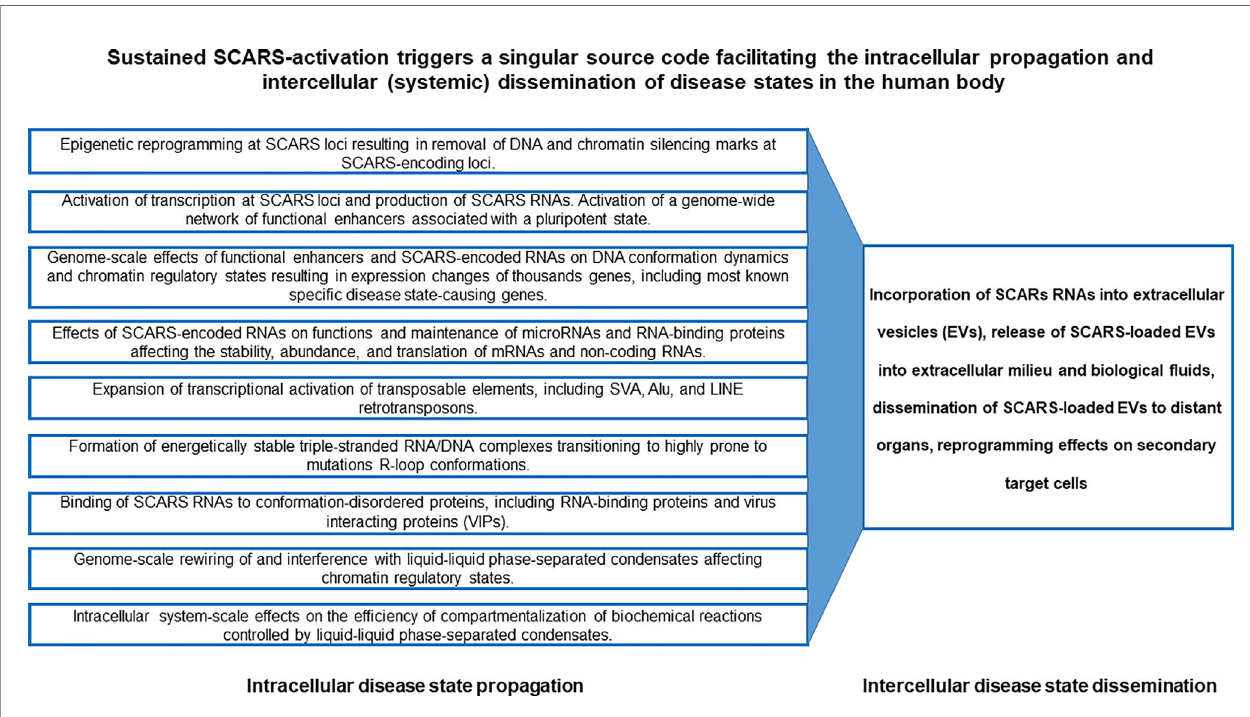
FIGURE 9 | SCARS-activation triggered singular source code facilitating the intracellular propagation and intercellular (systemic) dissemination of disease states in the human